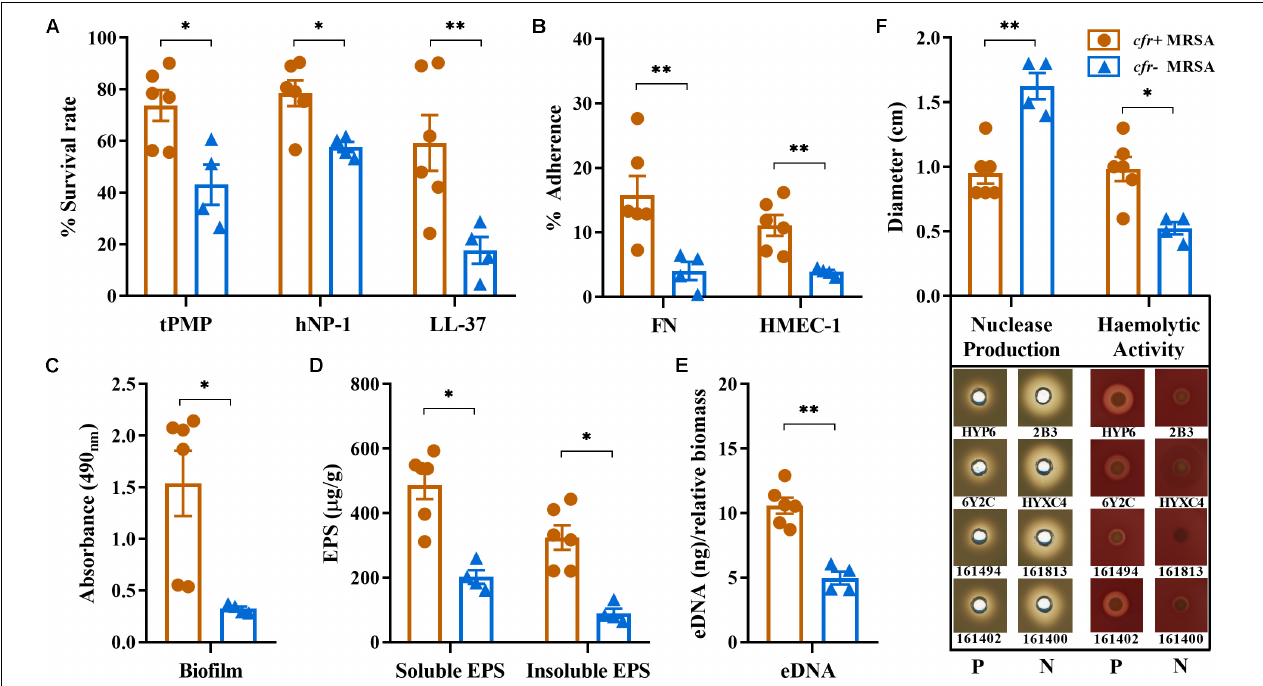
FIGURE 2 | Relevant phenotype differences between cfr -positive and -negative MRSA strain. (A) In vitro susceptibilities to tPMP, hNP-1, and LL-37; (B) Adherence to immobilized FN and HMEC-1. (C) Biofilm formation by the study MRSA isolates based on absorbance values (OD 490nm ). (D,E) Water-soluble and insoluble EPS and eDNA present in static biofilms. (F) Nuclease production and hemolytic activity of the study MRSA isolates on DNase agar and sheep blood agar plates, respectively. Diameters of zones clearance (cm) are indicated. Each dot represents one strain with three biological replicates. All data are presented as means ± SD. P, cfr -positive MRSA; N, cfr -negative MRSA ( ∗ P < 0.01; ∗∗ P < 0.005).